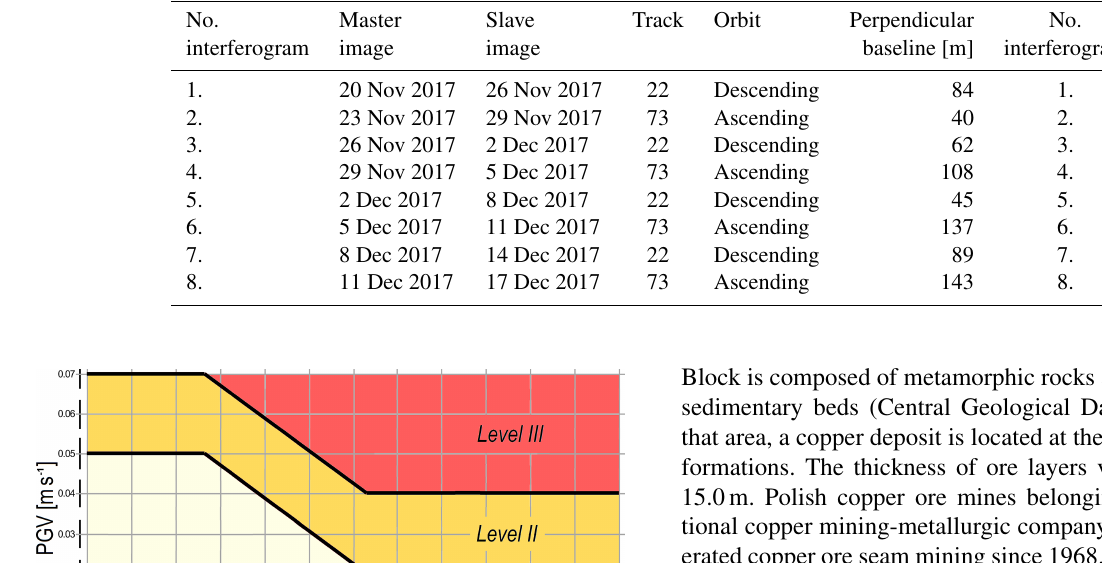
Table 1. Sentinel-1 images used in the research (Witkowski, 2019).